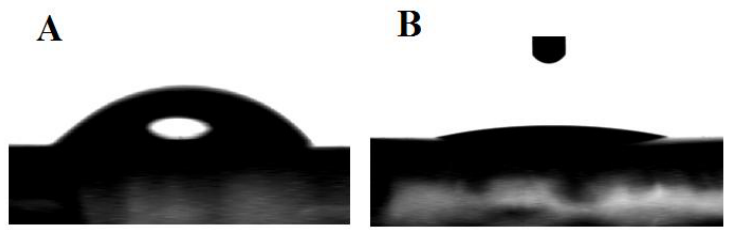
Figure 3. CV of ( A ) bare gold electrode, ( B ) MPA functionalization, and ( C ) antibody binding. The measurements were made in the presence of Fe(CN with scan rate of 100 mV/s.